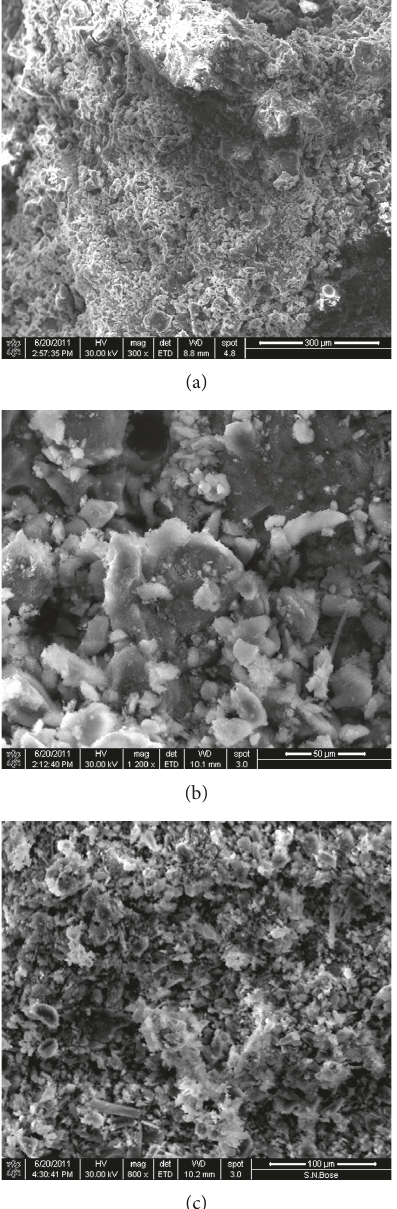
Figure 8: (a) Outer surfaces of sample SMSB2 at 3 days (a), 30 days (b), and 60 days (c) from the end of heat